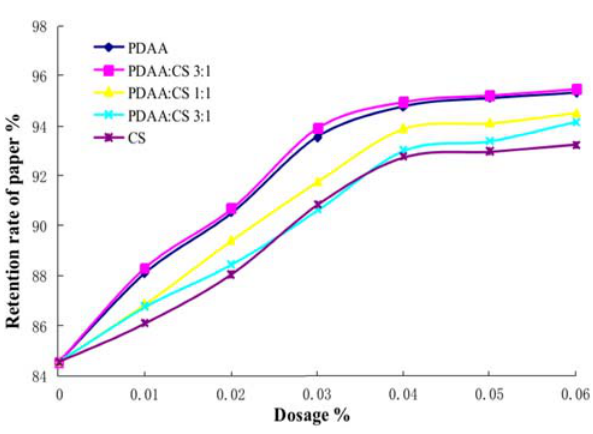
Figure 8: Synergistic retention of PDAA/CS. The molecular weight of PDAA is 4 million.